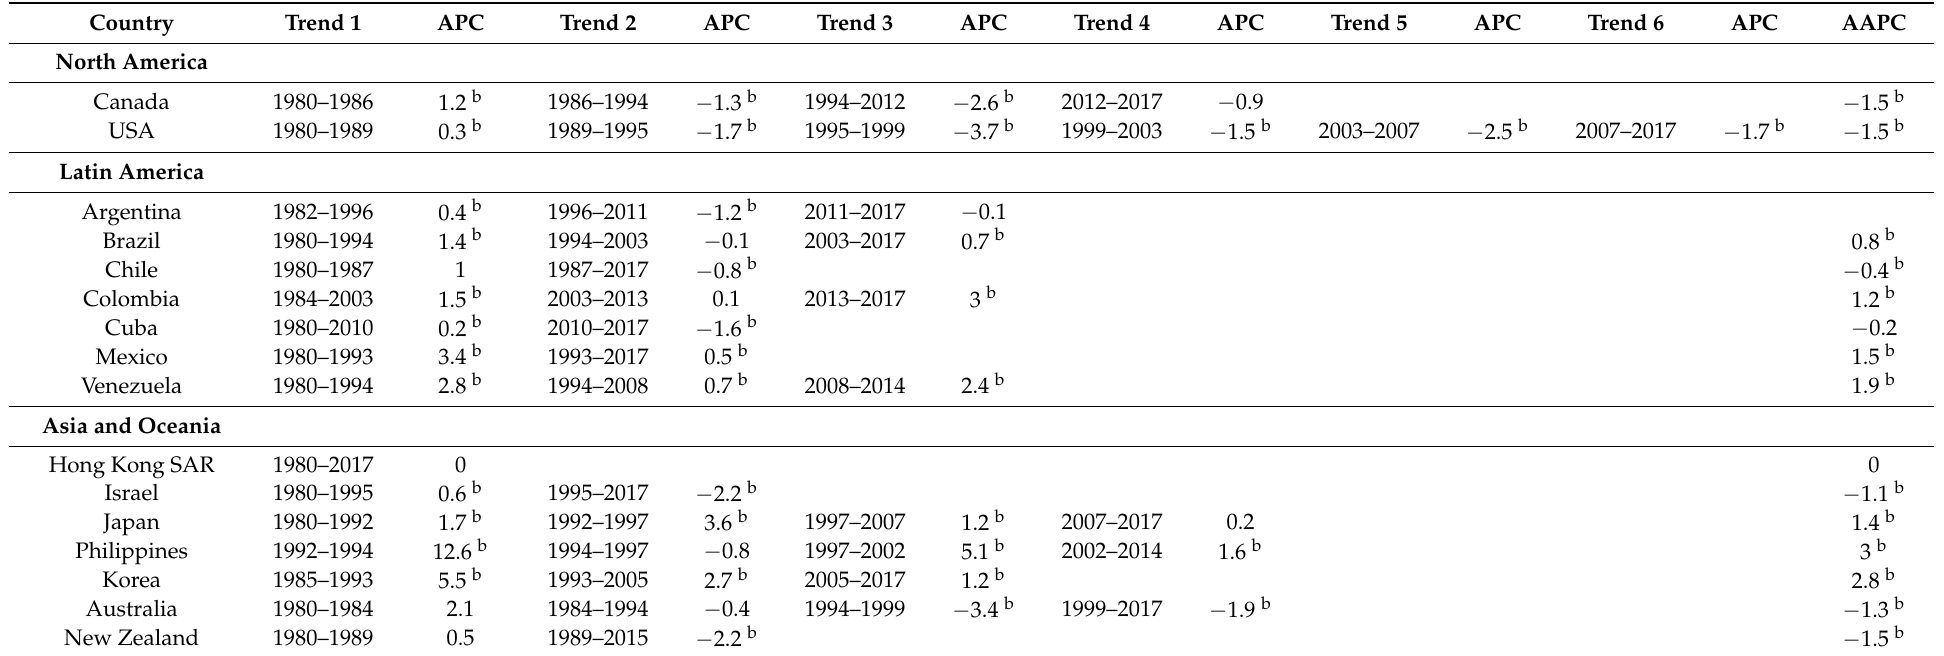
Table 3. Joinpoint analysis for breast cancer mortality trends over the 1980–2017 period (according to data availability a